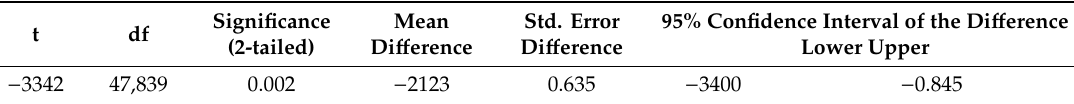
Table 6. Di ff erence in the number of checklist items between articles written before 2010 and articles written after 2010 (using the Independent Samples t